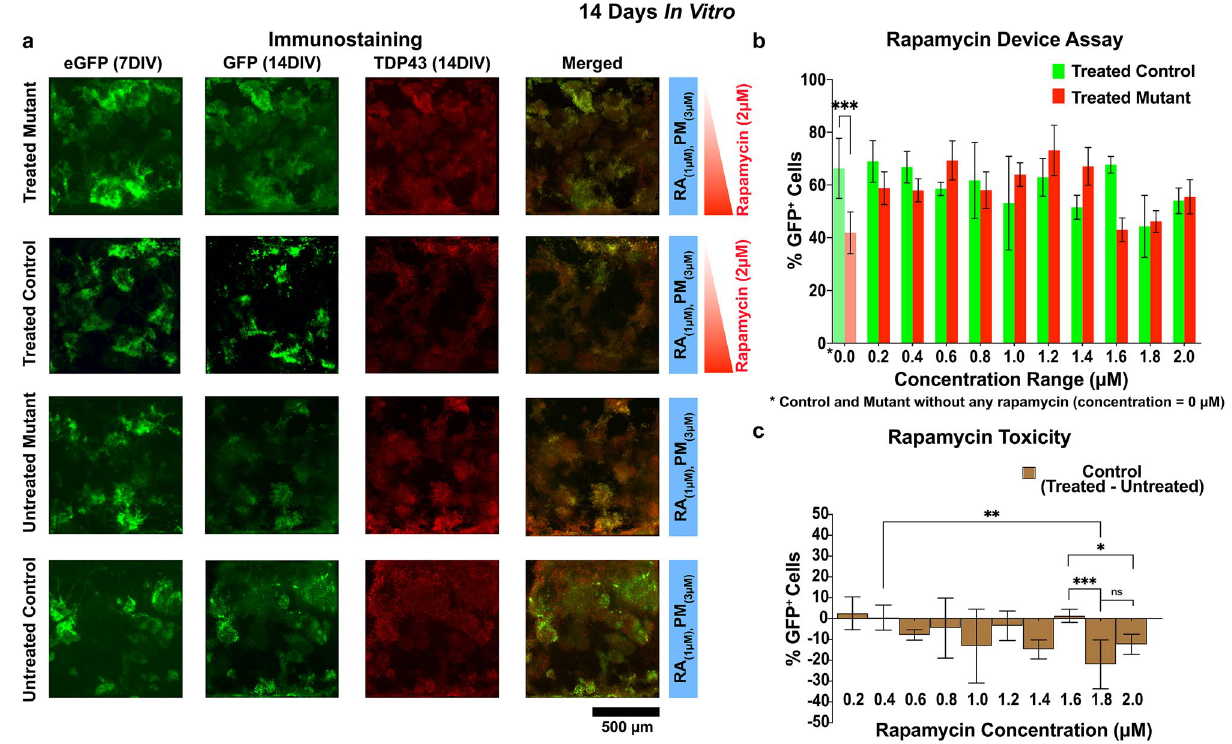
Figure 6. Rapamycin assay in microdevice (14DIV). ( a ) Typical microdevice immunostaining for GFP and TDP-43 at 14DIV under a rapamycin gradient. Red sidebars immediately to the right indicate the spatial direction of the rapamycin gradient (red: 0 –2 µM) while the blue bars indicate a constant concentration of culture media morphogens. ( b ) Plots the average (n ≥ 4) percent viability of rapamycin treated MNs (GFP + ) i.e. viability of treated mutant MNs (red) and treated control MNs (green) as a function of rapamycin concentration. *Indicates both mutant and control MNs which are not exposed to rapamycin, i.e. untreated MNs respectively. ( c ) Shows the relative MN toxicity of rapamycin on control MNs, i.e. the percent viability of rapamycin treated control MNs minus the average viability of rapamycin untreated control MNs. A positive ( +) value indicates an increased survival of control MN’s without rapamycin and a negative (−) value indicates a toxicity effect of rapamycin. P values: Non significant (ns) P > 0.05, *P ≤ 0.05, **P ≤ 0.01, ***P ≤ at the two boundaries (source and sink) were continually refreshed with reagent flow from the microchannels, i.e., boundary concentrations kept constant (Figure S3b). Rapamycin assay in the microdevice. ES cells, both control and mutant, were differentiated into MNs for 7 DIV in the microdevice using standard MN differentiation media according to protocols outlined in the methods Sect. (4.4). A MN cell identity was confirmed by expression of the Hb9::GFP reporter (eGFP). At 7DIV, the MNs were then exposed to a linear rapamycin gradient for the remaining duration of the experiment by introducing